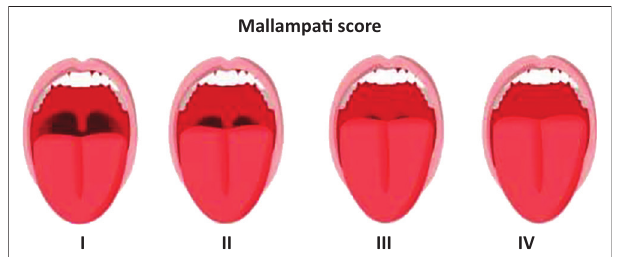
FIGURE 1: Mallampathi